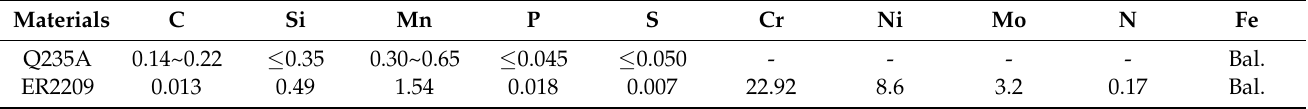
Figure 1. WAAM process. ( a ) Schematic diagram of CMT wire and arc additive manufacturing. ( b ) Extraction and size of tensile samples. Table 1. Chemical composition of base metal and welding wire (wt.%).